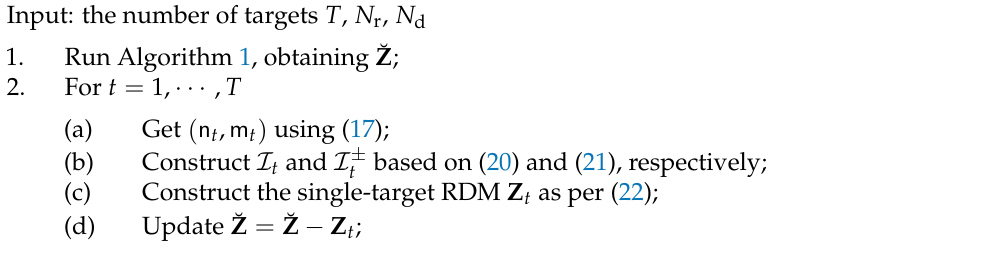
Algorithm 4 Sequential target detection and